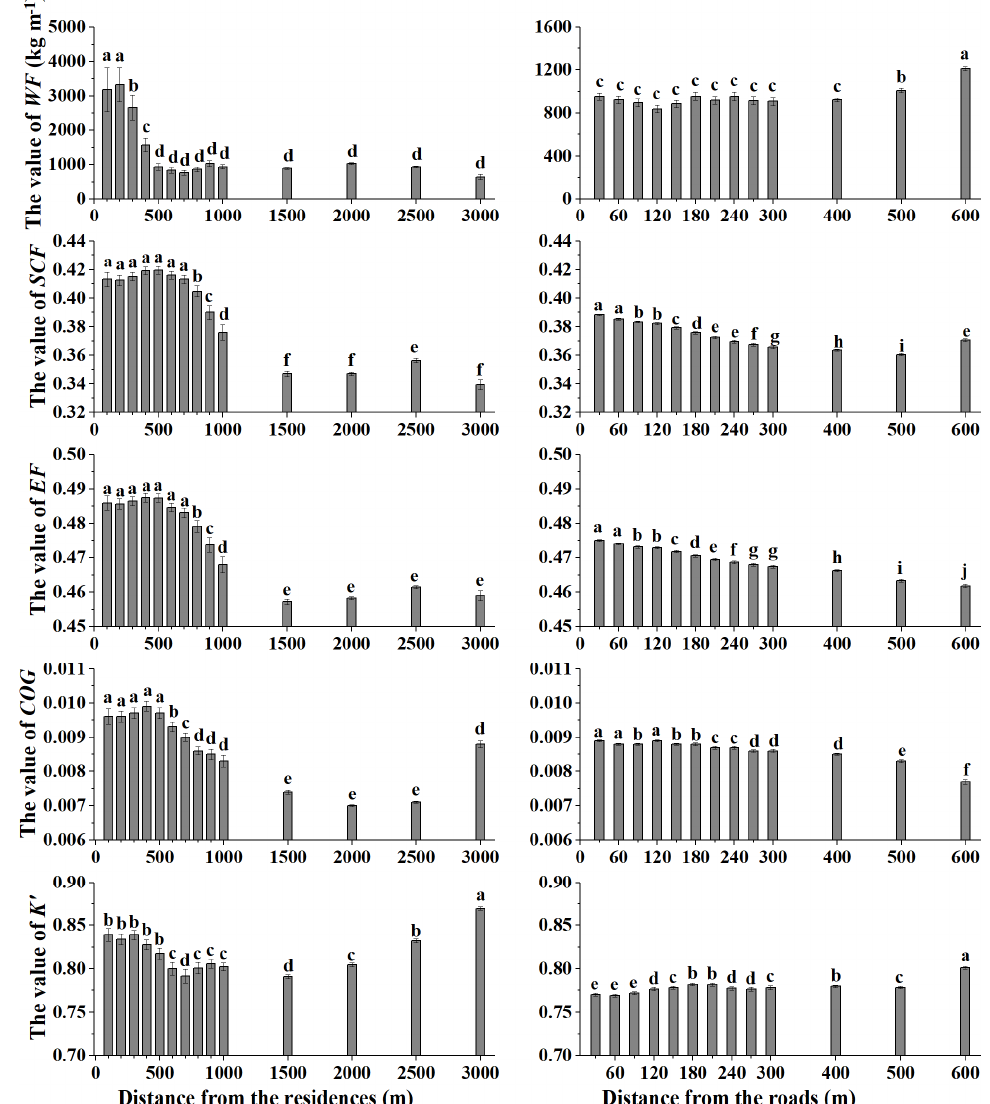
Figure 5. Variation in wind erosion factors ( WF , SCF , EF , COG, and K’ ) for different buffer distances from residences and roads. Lowercase letters indicate the differences in each wind erosion factor for different distances ( P < 0.01).